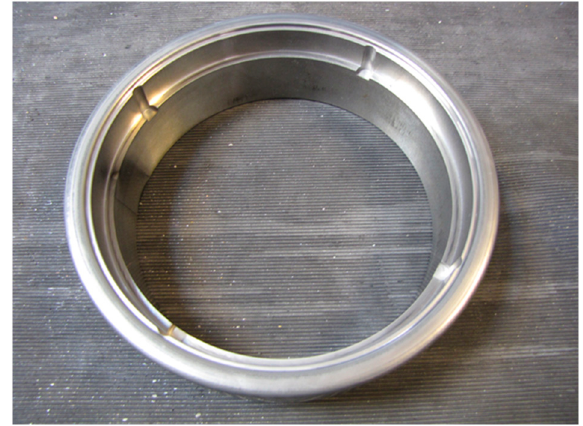
Figure 4. View of the already coated pressure ring which was used in the industrial tests.